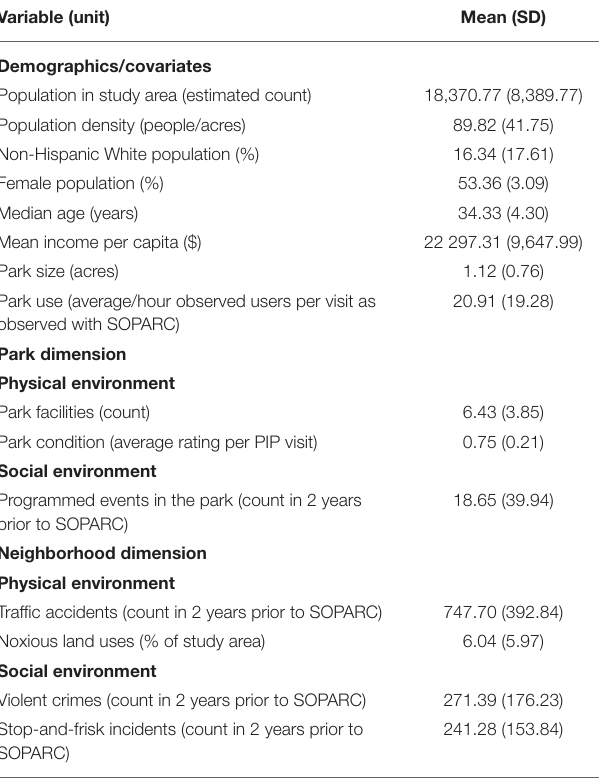
TABLE 2 | Descriptive statistics for Model 1 (community-level analysis, n = 54 parks).